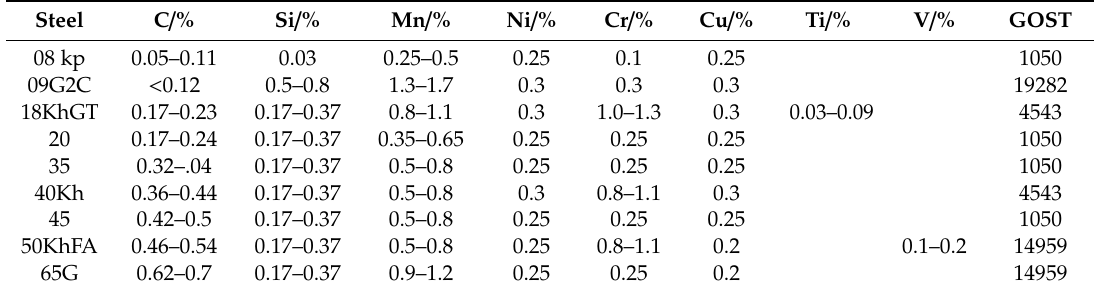
Table 1. The chemical composition of steels adopted for experimental research.